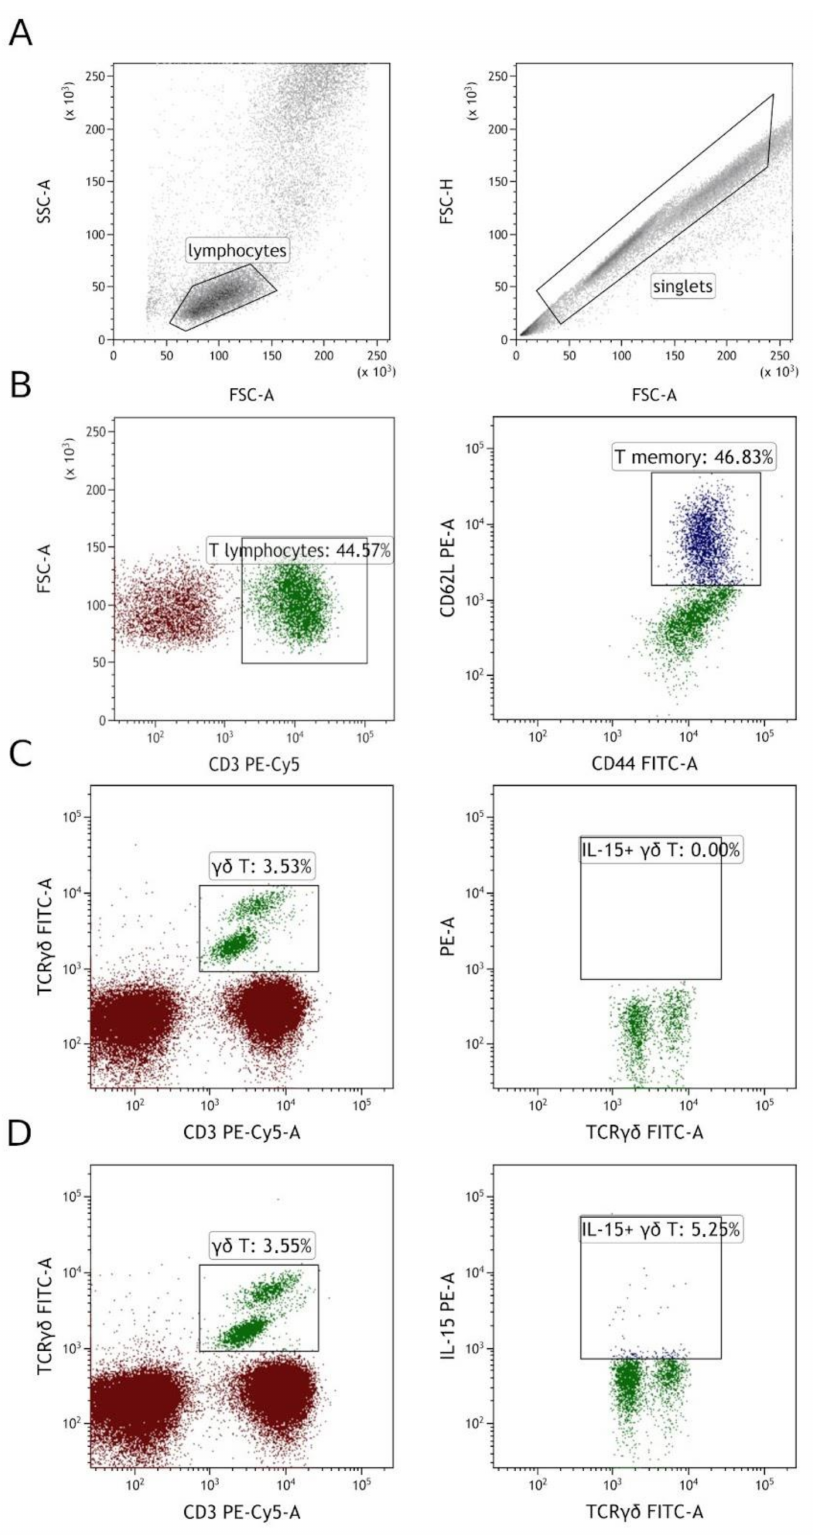
Figure 2. Gating strategy. ( A ) Firstly, singlets were selected based on FSC-H vs. FSC-A, then lymphocytes were gated on SSC vs. FSC. ( B ) T memory cells were gated by first gating CD3+ cells from total lymphocytes, then by gating CD44/CD62L double-positive cells among T cells. ( C , D ) γδ T cells were gated on CD3 vs. TCR γδ . Then, among them, IL-15+ cells were gated, panel ( C ) shows FMO (fluorescence minus one) control, and panel ( D ) shows IL-15+ gating on the same